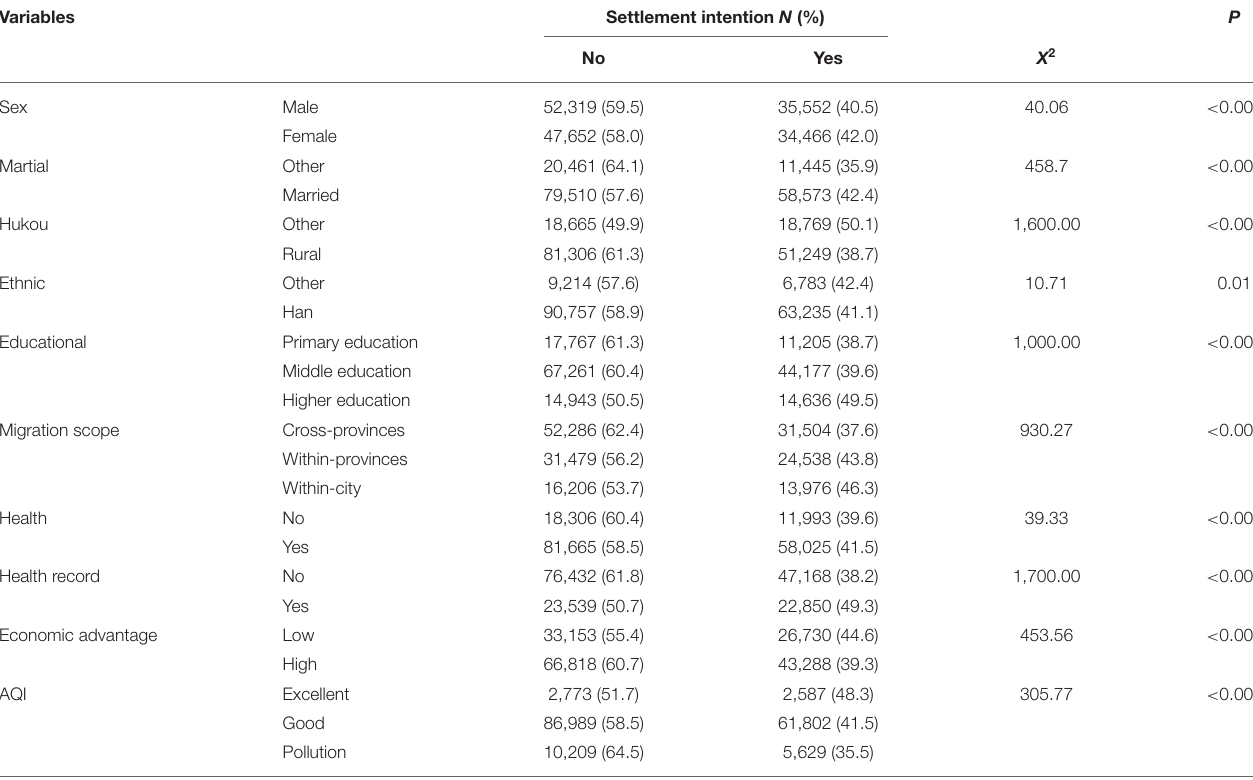
TABLE 2 | Comparison of settlement intention among different groups. Variables